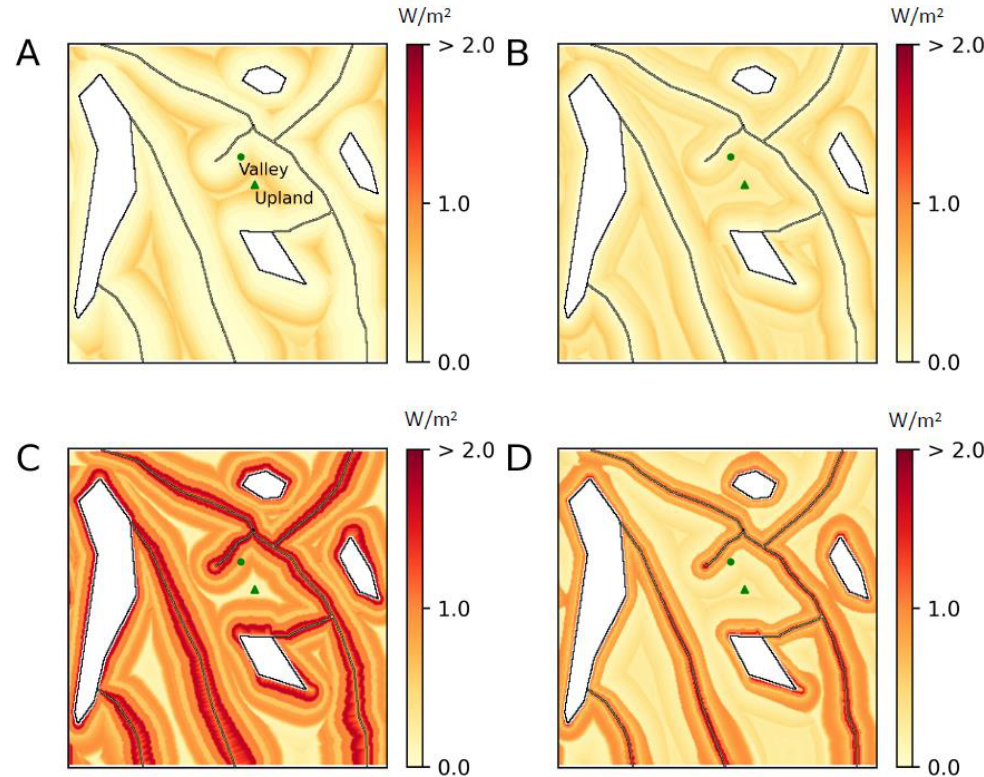
Figure 10. Maps of total recharging heat flow at the water table in watts per square meter (W/m 2 ) for the ( A ) MID_TRENDED simulation in the month of March after 15.25 years of warming, ( B ) HI_TRENDED simulation (also in March) after 15.25 years of warming, ( C ) MID_TRENDED simulation in the month of August after 25.67 years of warming, and ( D ) HI_TRENDED simulation (also in August) after 25.67 years of warming. The plotted total heat flow is the sum of the convective, conductive and dispersive heat flows.